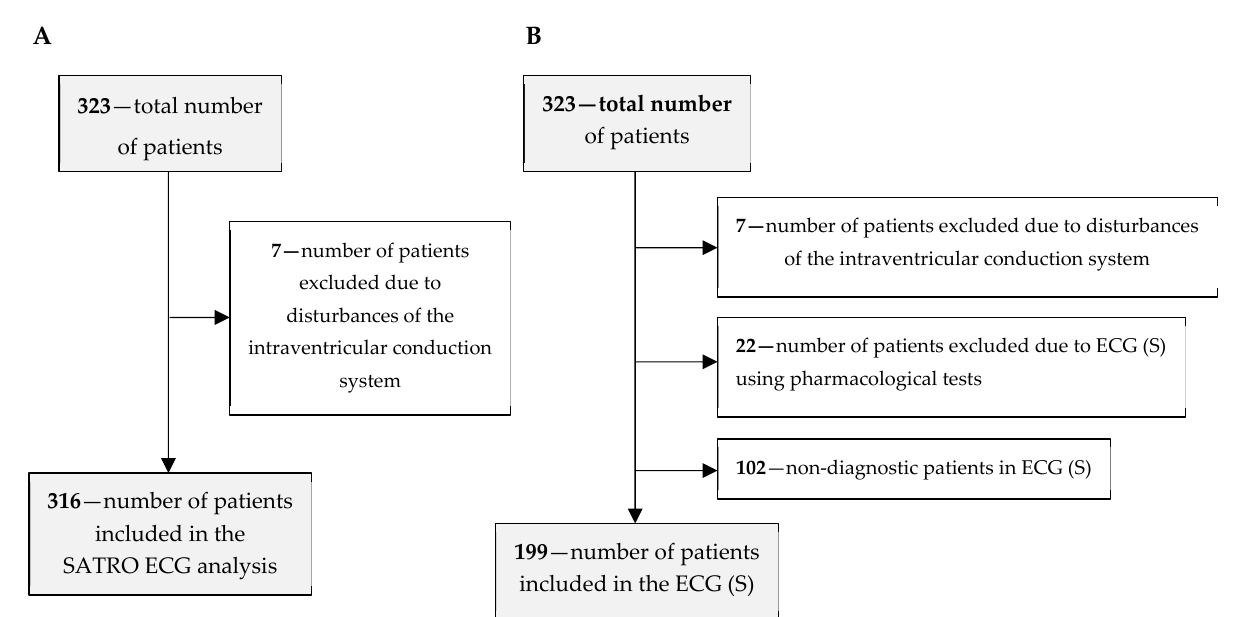
Figure 1. Flow of study participants for the assessment of diagnostic effectiveness: ( A ) without the results of the ECG (S) test, ( B ) for all diagnostic methods.